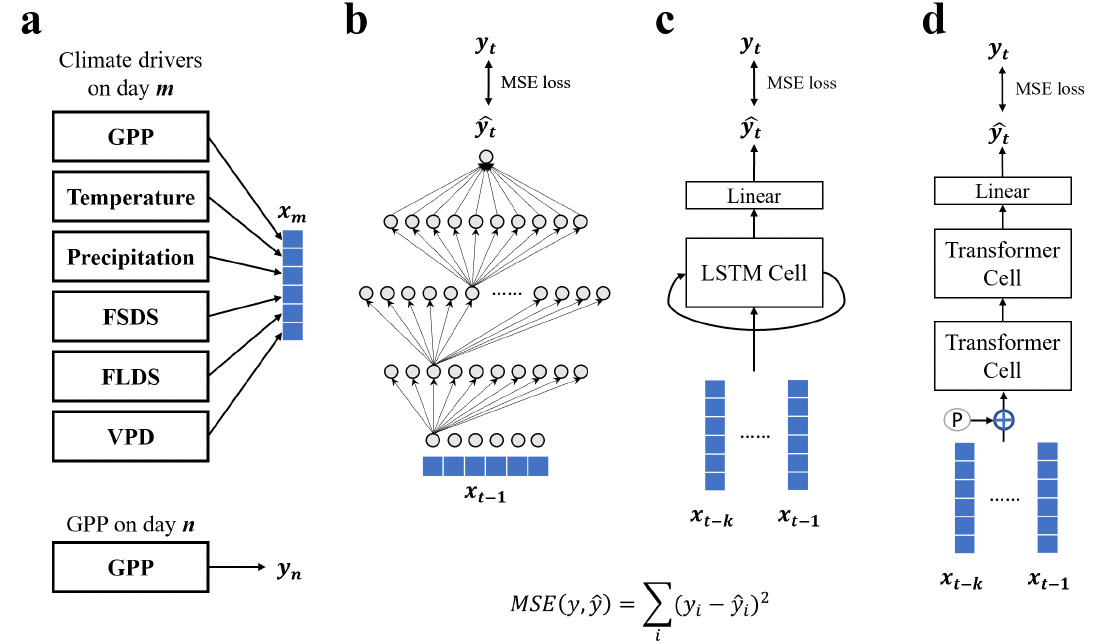
Figure 4. Complete depiction of the three neural network candidates used in our study. ( a ) The feature vectors and ground truths. The candidates take in the feature vectors as their inputs and generate predictions to approximate the ground truths. ( b ) Feedforward neural network (FFNN). Note: In each of the first three layers, only the connection from one chosen cell is drawn to avoid overcrowding the graph. In fact, every cell is connected to all cells in the adjacent layers. ( c ) Long short-term memory (LSTM). ( d ) Transformer. The symbols used are described in the next figure.